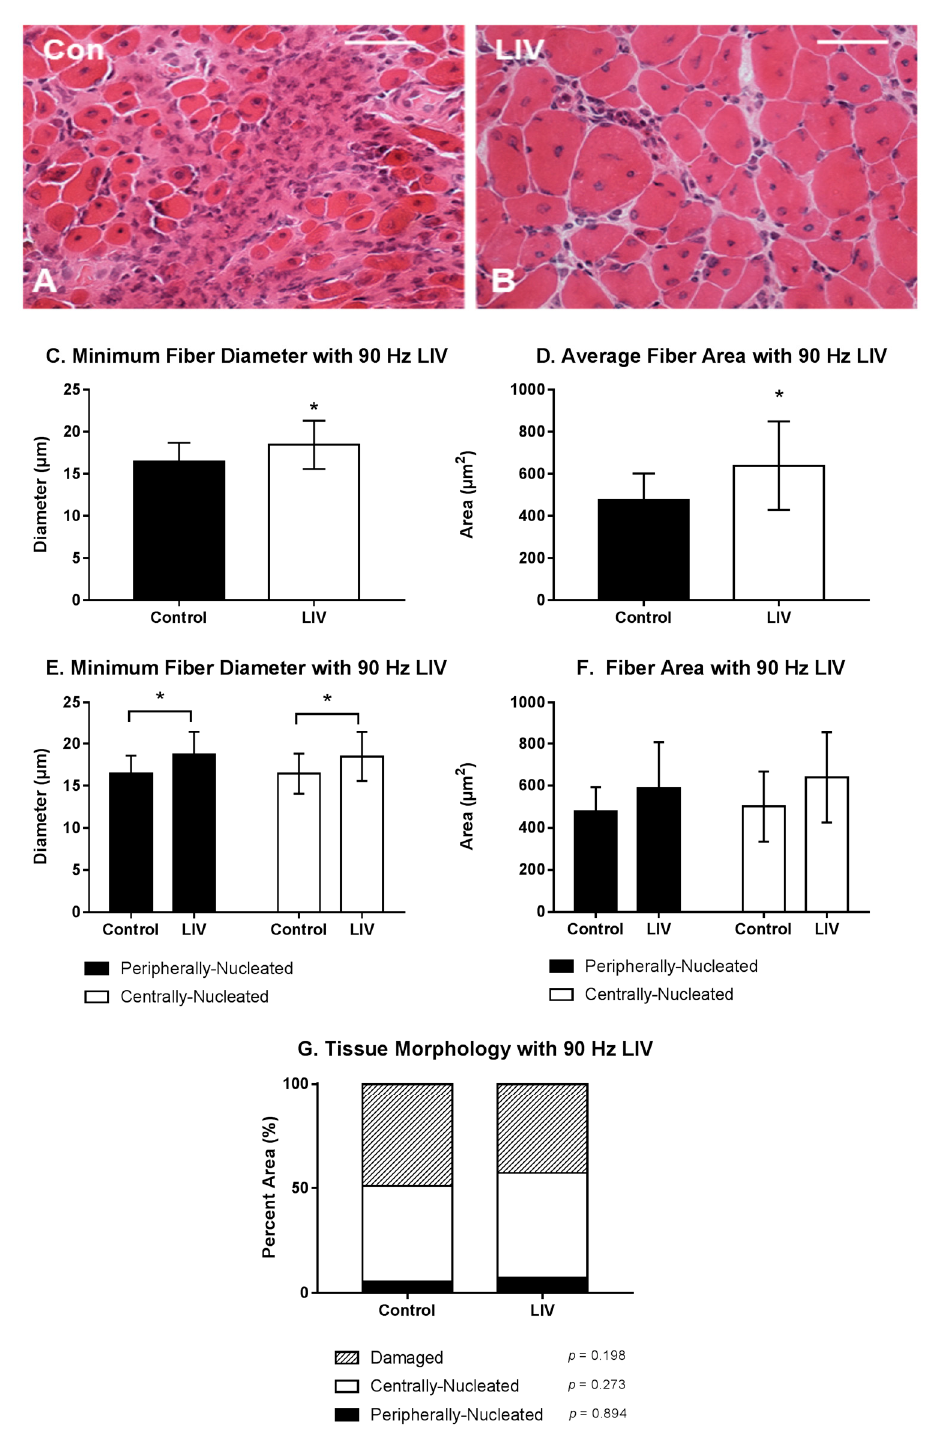
Figure 2. Low-intensity vibration (LIV) at 90 Hz and 0.2 g enhances myofiber growth at day 14 post-injury following laceration muscle injury in mice. Gastrocnemius muscles were lacerated and collected for histological analysis at day 14 post-injury. ( A , B ) Representative images of hematoxylin and eosin-stained sections (scale bar = 50 µ m, 40 × magnification); ( C , E ) Average minimum myofiber diameter; ( D , F ) average cross-sectional area of individual myofibers, and ( G ) percent area of injury that consists of peripherally-nucleated fibers, centrally-nucleated fibers, or damaged tissue was quantified in five 40 × fields per muscle in hematoxylin and eosin-stained sections. ( C , D ) All fiber types averaged together; ( E , F ) Myofibers grouped by type. Data are presented as mean ± SE. * p ≤ 0.05.